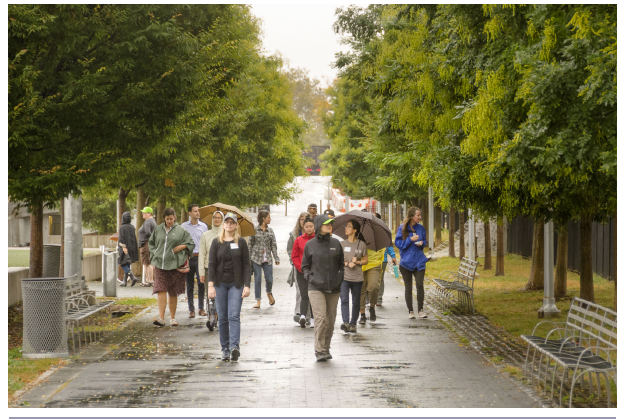
Fig. 1 . Learning from Place workshop participants explore Bushwick Inlet Park for inspiration to create origin